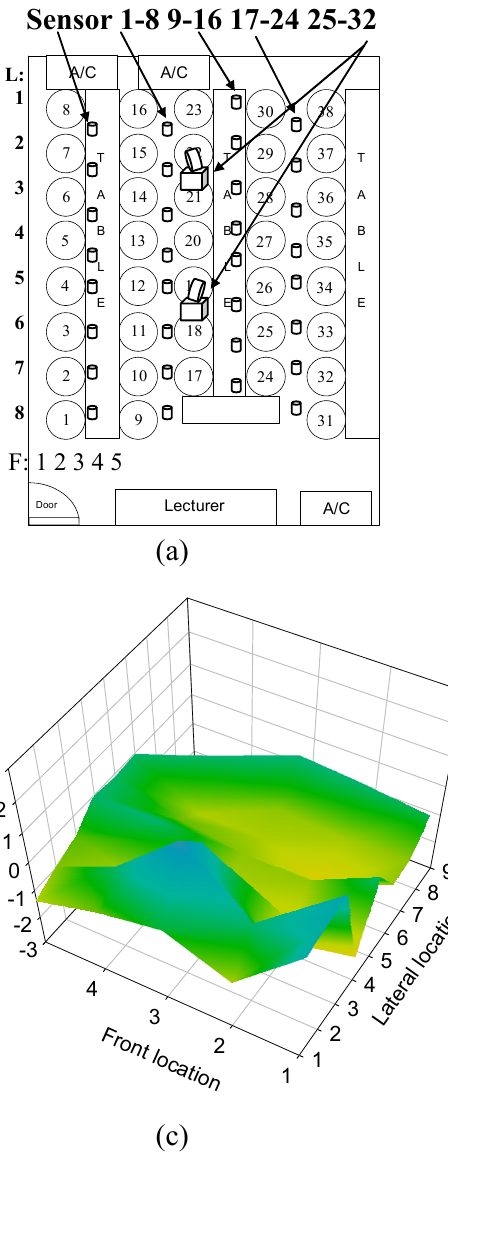
Figure 6. The comparison of CSV obtained by human vote and PMV measured in a practical space. Panel (a) shows the arrangements of the space, a computer classroom with thirty eight seats for participants. Panel (b) gives the vote of participants. The PMV measured results in space that obtained by the sensor networks with the extrapolated estimation and the maximum entropy method are shown in (c) and (d)